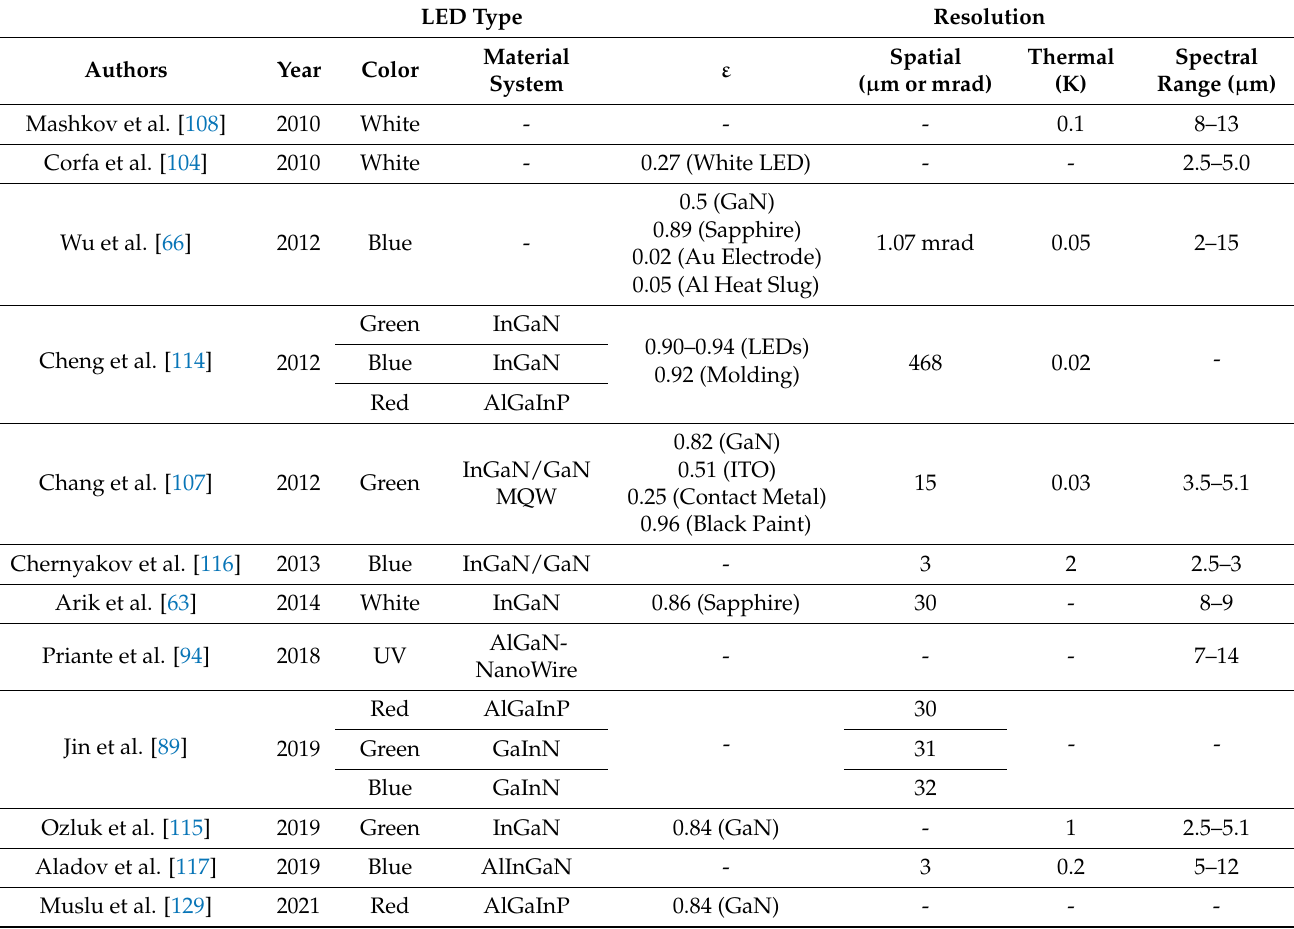
Table 2. IR thermography parametric summary for the employed parameters in the literature for the temperature measurement of LEDs. References are sorted by year. Not reported parameters are indicated by a hyphen in the table. ( ε :